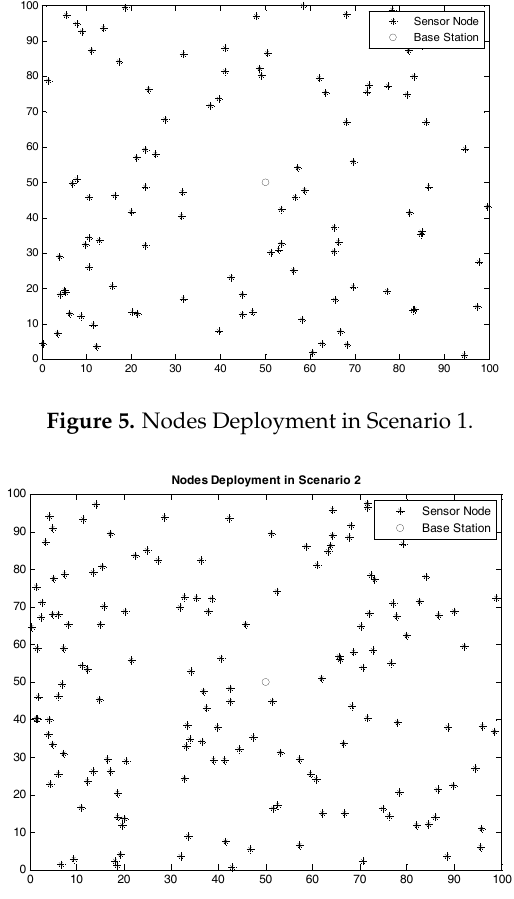
Figure 6. Nodes Deployment in Scenario 2.